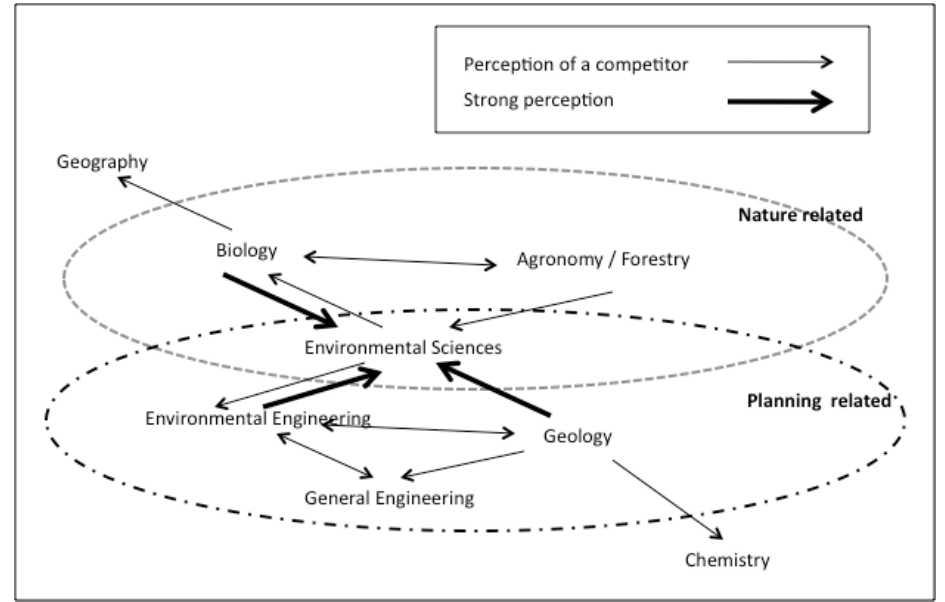
Figure 5. Two fields of inter-professional competition among Swiss environmental professionals (cf. Mieg & de Sombre,